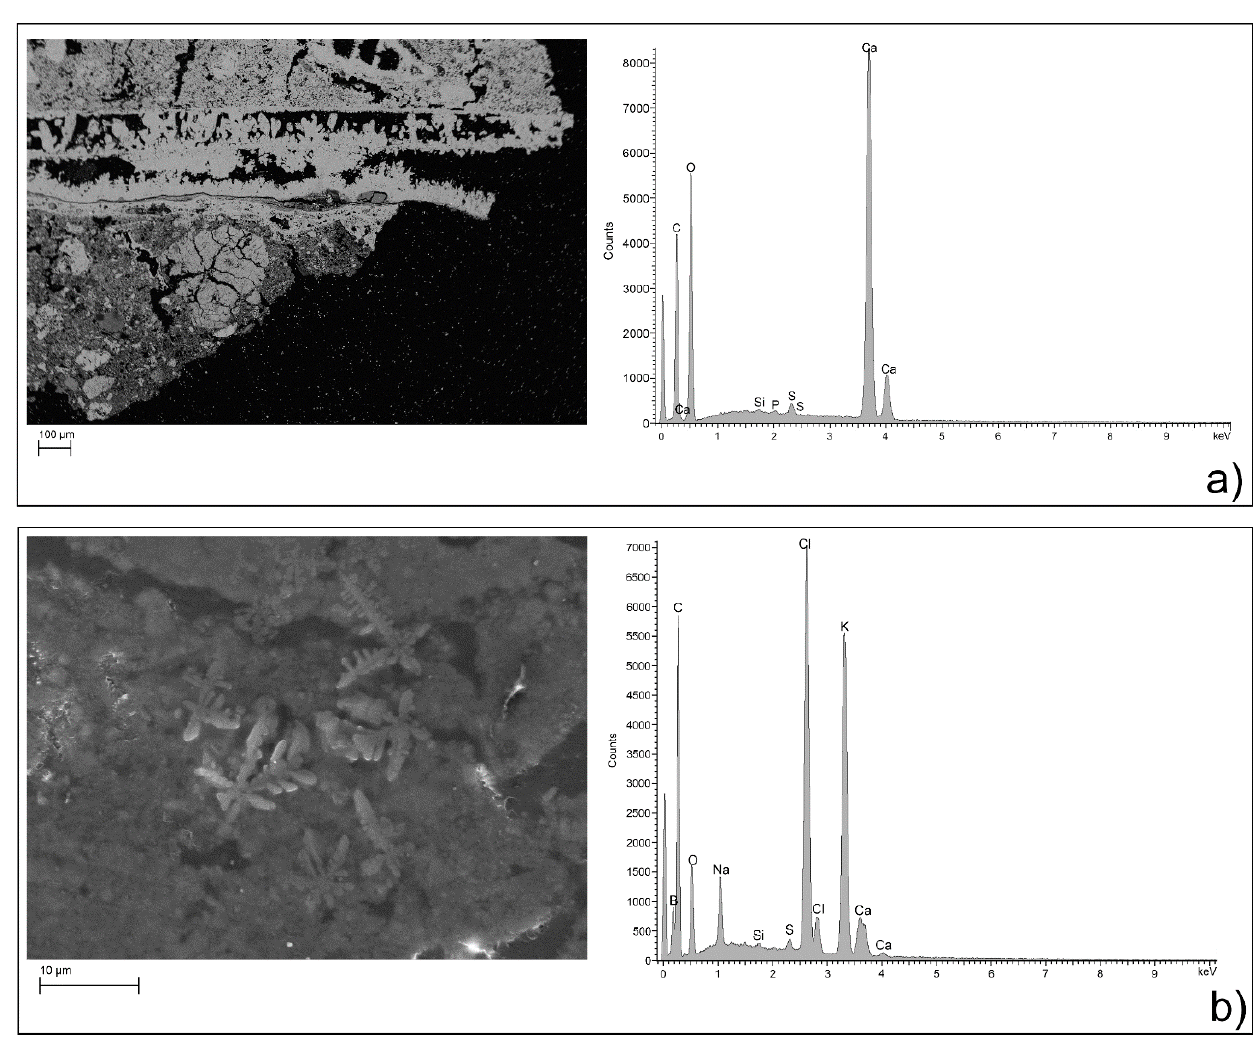
Figure 12. ( a ) SEM-BSD (back-scattered detector) image ( left ) of a thick surface encrustation composed almost exclusively by calcium and oxygen (EDS graph on the right ). ( b ) SEM-BSD image ( left ) showing the presence of secondary phases in the preparatory plaster layers composed by chlorine, potassium, sodium and sulfur (EDS graph on the right ).